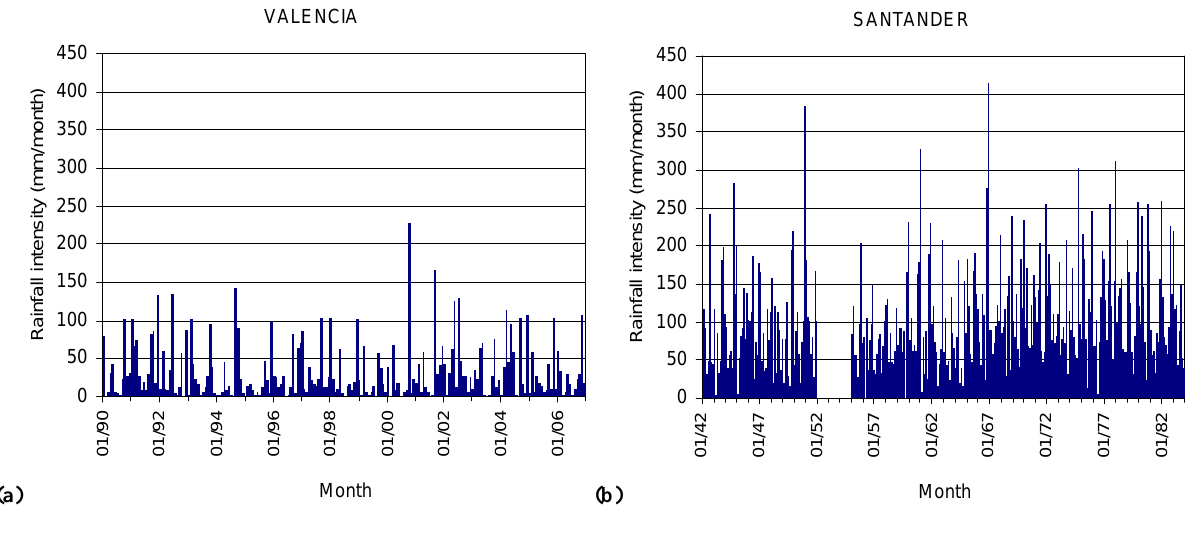
Fig. 1. Monthly rainfall time series for Valencia and Santander.